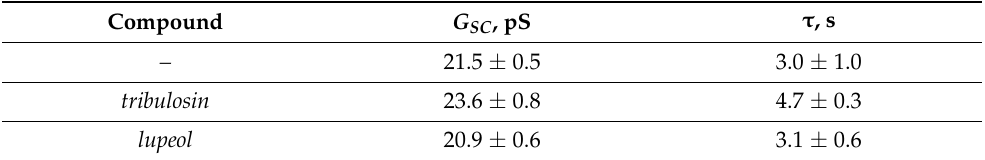
Figure 3. ( a ) Current fluctuations corresponding to the openings and closures of single GrA channels in the absence ( control ) and presence of 50 µ M tribulosin or lupeol. V was equal to 100 mV. C —closed state of the channel, O —open state of the channel. ( b ) G ( V ) curves of single GrA channels in the absence ( ■ ) and presence of 50 µM tribulosin ( ● ) and lupeol ( Δ ). The membranes were composed of DPhPC and bathed in 1.0 M KCl (pH 7.4). Table 2. The parameters of single GrA pores in the absence and presence of 50 µ M of tribulosin and lupeol: G SC —the pore conductance at V = 100 mV; τ —the dwell time of GrA channel. The lipid bilayers were composed of DPhPC and bathed in 1 M KCl (pH 7.4).